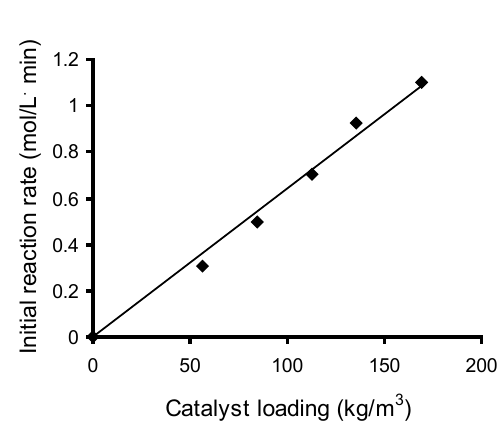
Figure 2. Initial reaction rate versus catalyst loading; molar ratio acetic acid – epichlorohydrin 1:1; temperature 366 K; stirring speed: 600